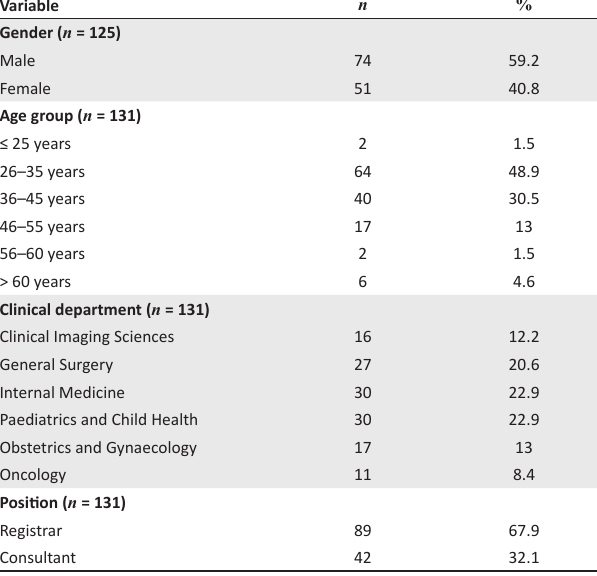
TABLE 2: Demographic information of participating